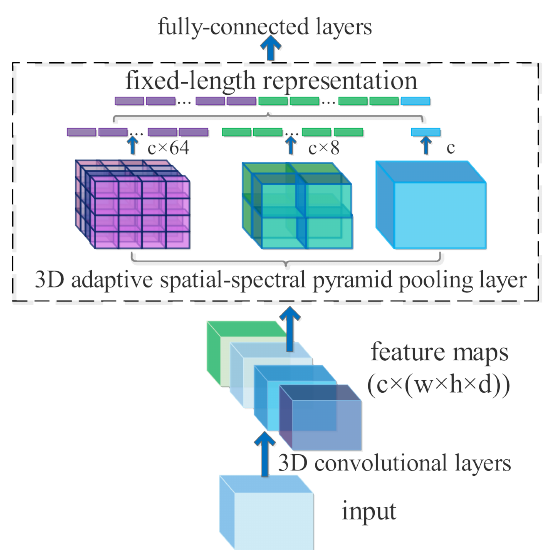
Figure 5. A CNN structure with 3D adaptive spatial-spectral pyramid pooling (ASSP) layer. Here c is the number of filters in the last convolutional layer. This 3D ASSP contains a three-level pyramid with different scale are 4 × 4 × 4, 2 × 2 × 2 and 1 × 1 × 1,